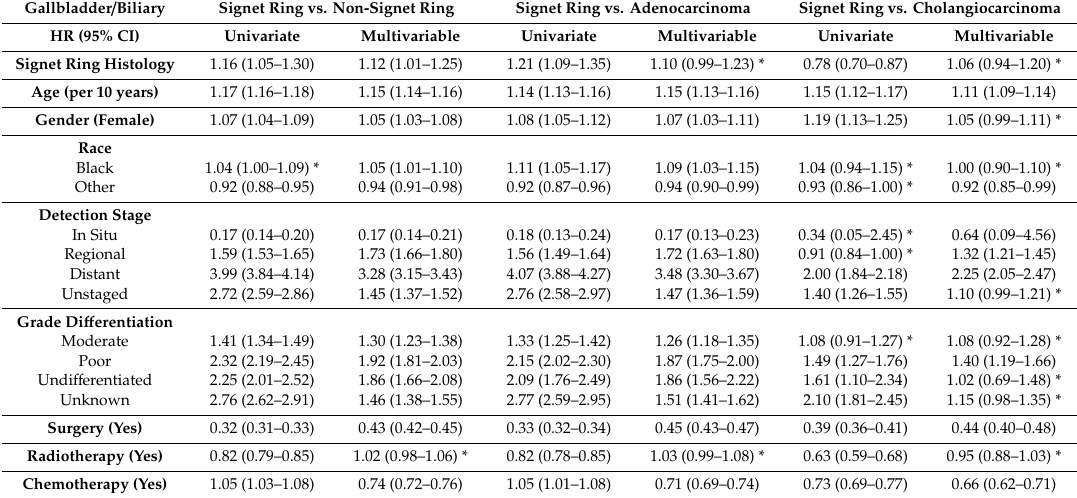
Table 16. Derived univariate and multivariable Cox-proportional hazard ratios (HR) of mortality for gallbladder / biliary cancers. Signet Ring vs. Non-Signet Ring Signet Ring vs. Adenocarcinoma